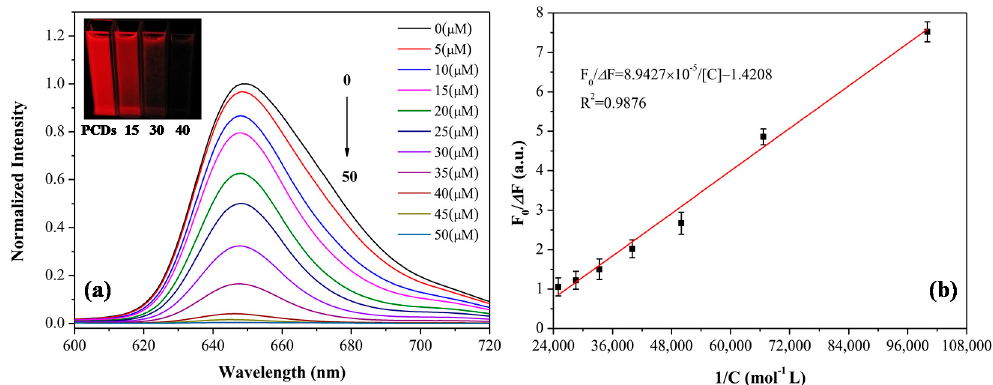
Figure 6. ( a ) Fluorescence of the PCDs quenched by different concentrations of Eu 3+ (0, 5, 10, 15, 20, 25, 30, 35, 40, 45, 50 μ mol·L − 1 ); inset: The photographs of PCDs (left) and PCDs in the presence of 15, 30, 40 μ mol·L − 1 Eu 3+ (from left to right) on the exposure of UV light. ( b ) Modified Stern–Volmer representation of PCDs after titration with Eu 3+ .